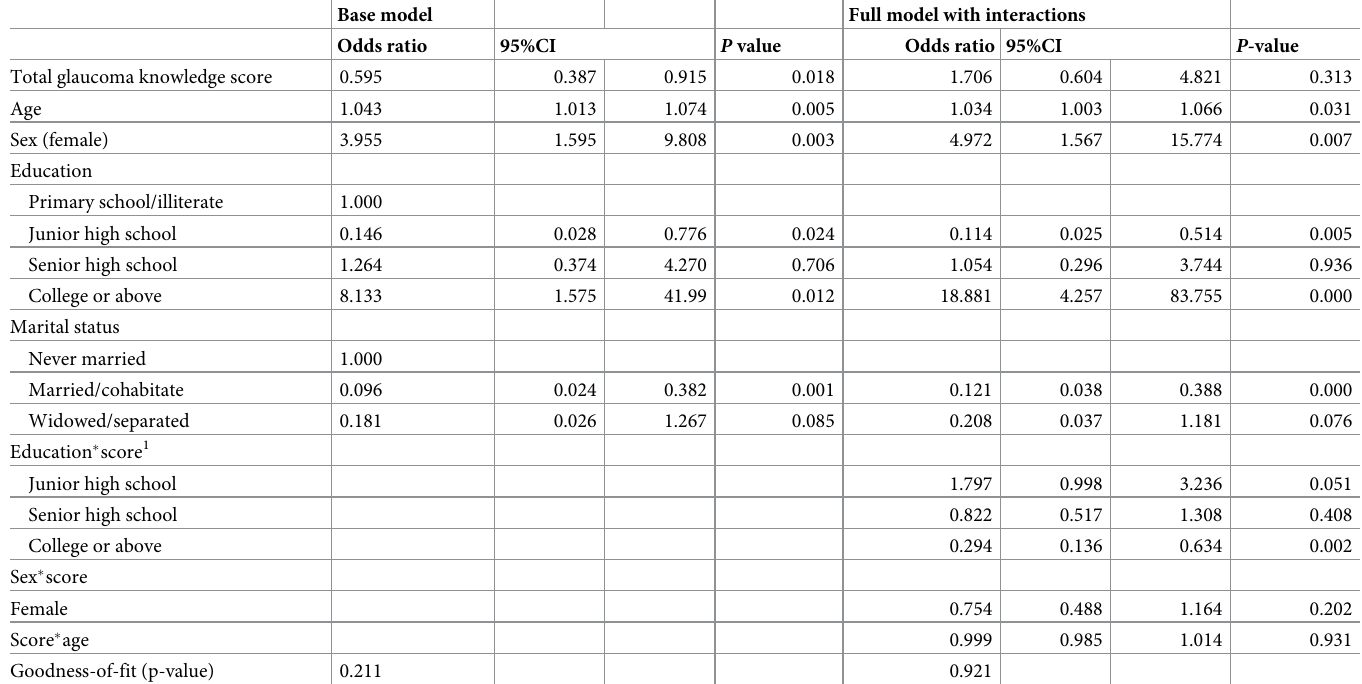
Table 3. Logistic regression for factors associated with high risk,